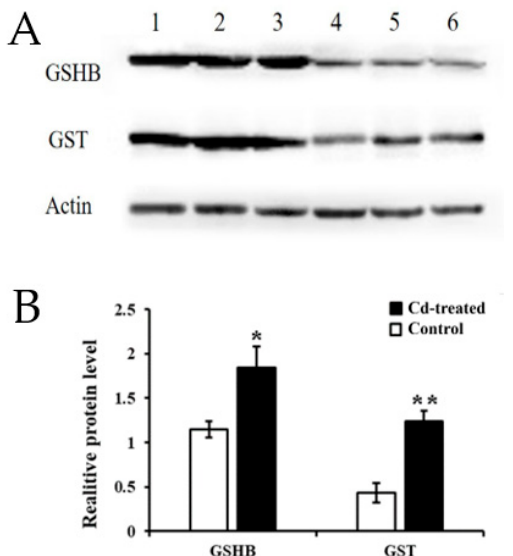
Figure 6. Relative expression of target genes in the hairy roots of Brassica campestris L. ( A ) Expression of GST and GSH protein. Lines 1, 2, 3 Cd treatment (200 µ M for 24 h); 4, 5, 6: control group; ( B ) Grayscale analysis. (* p < 0.05, ** p < 0.01).